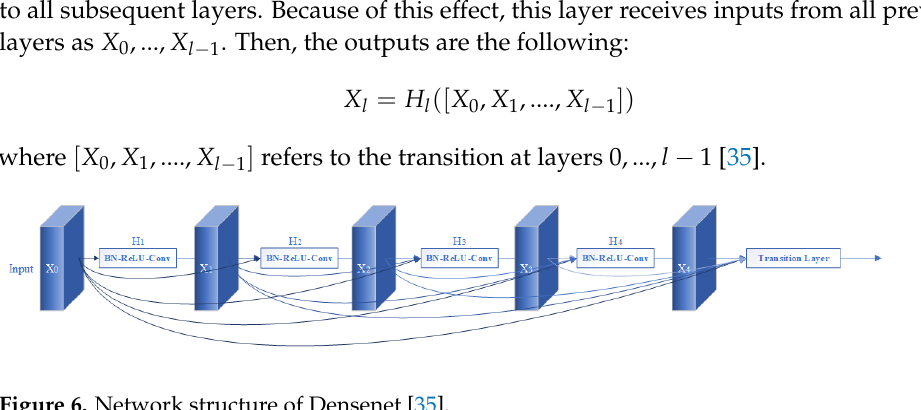
Figure 6. Network structure of Densenet [35].